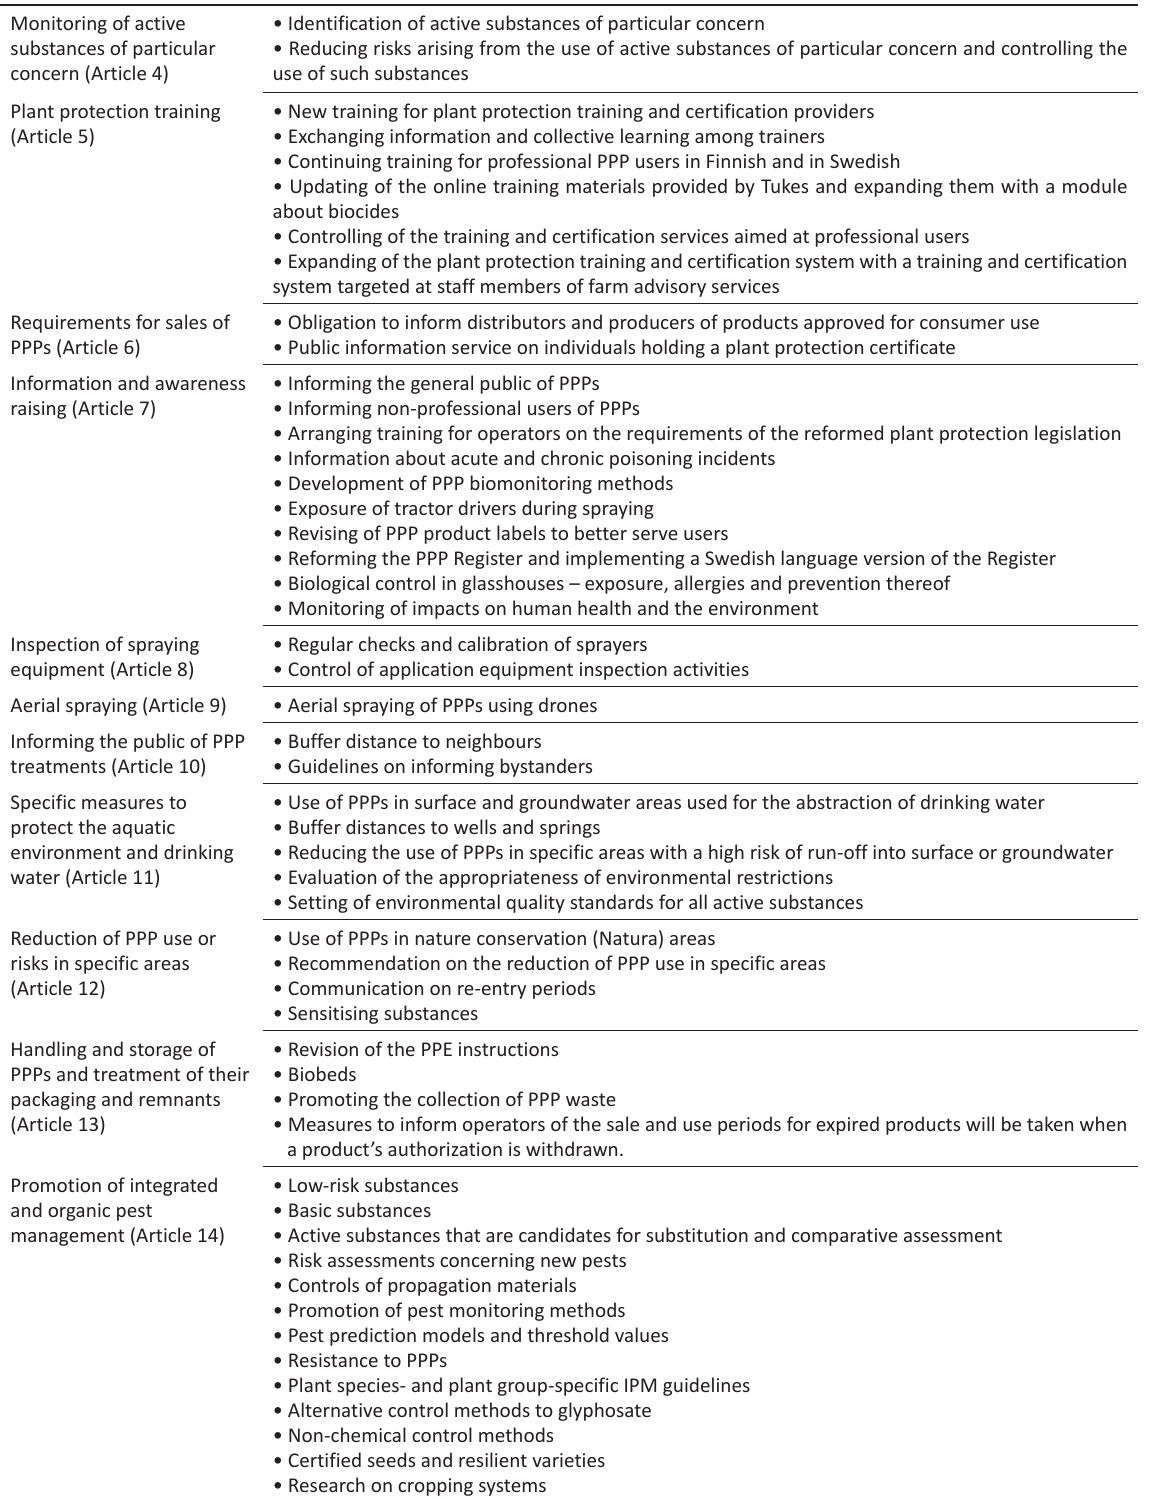
Table 1. Overview of the measures of the Finnish NAP II with reference to respective Articles of the Directive